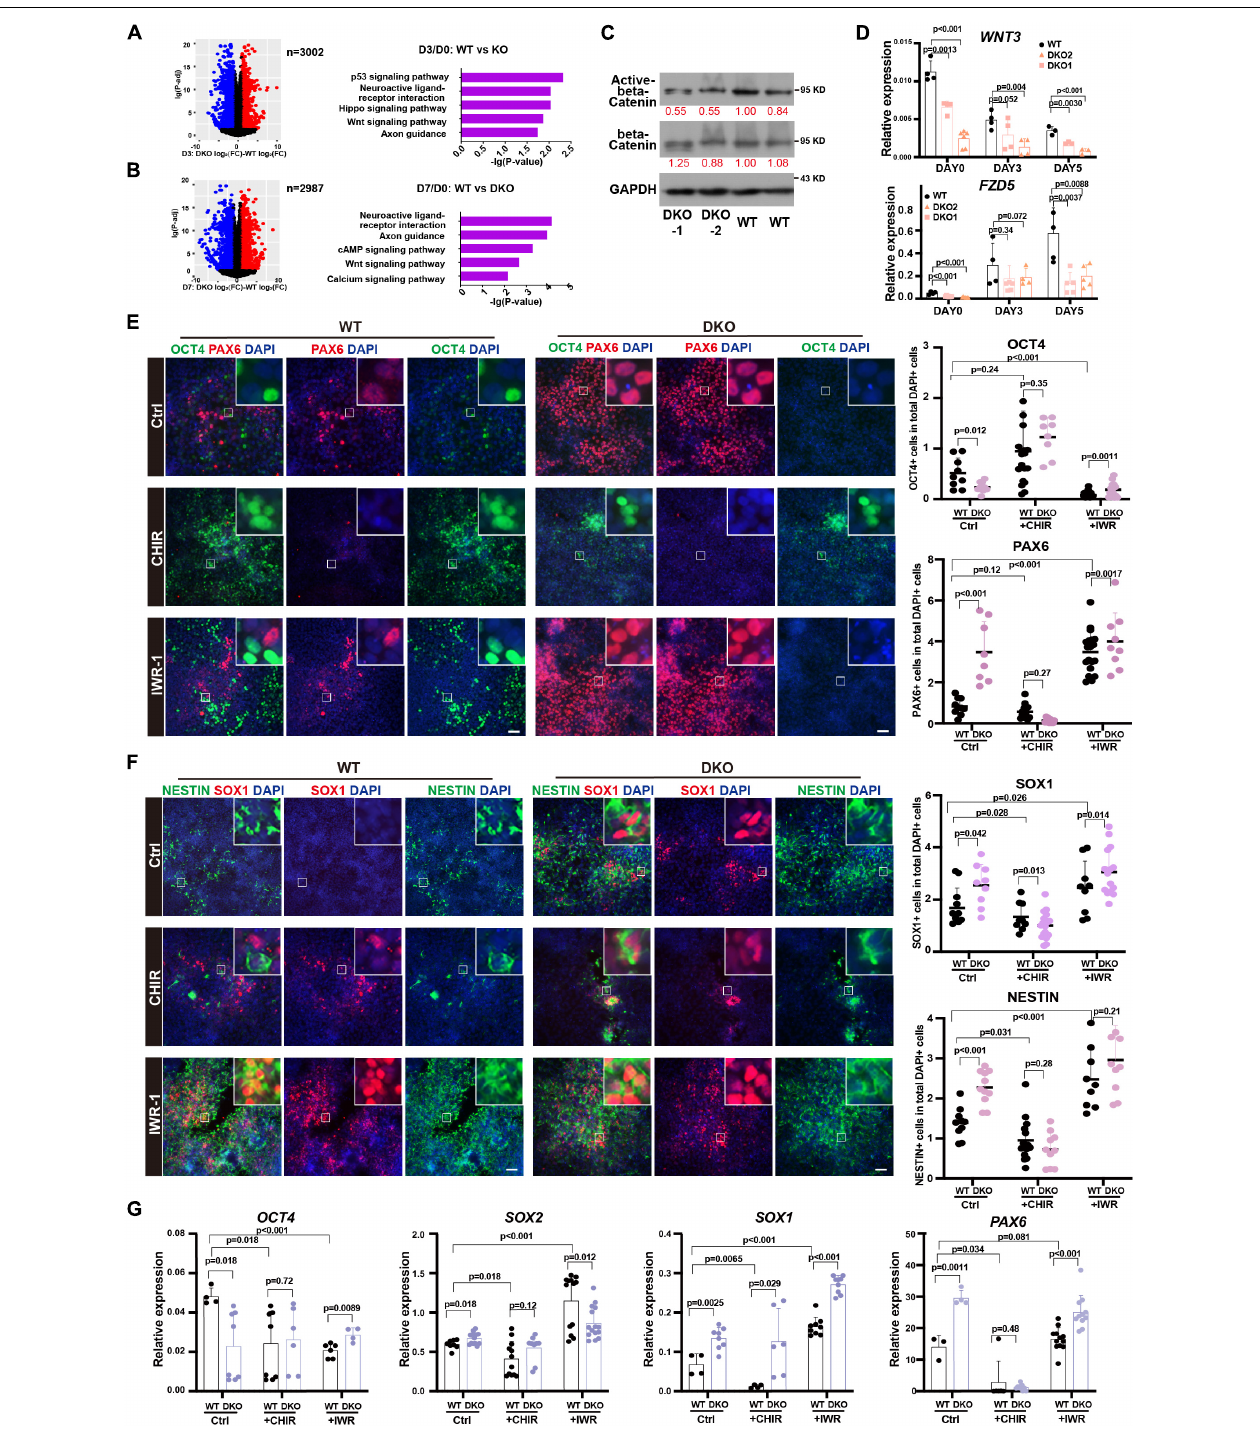
FIGURE 6 | WNT signal pathway contributed to the function of KDM6 during neuroectoderm differentiation. (A,B) KEGG analysis of abnormal activation or repression during neuroectoderm differentiation caused by KDM6 knockout based on conditional effect differential expression analysis at differentiation day 3 (A) and day 7 (B) over undifferentiated state. (C) Western blot assay showing the signal intensity of active beta-catenin and total beta-catenin in KDM6-DKO cells and wild-type cells. GAPDH works as the loading control. (D) The RT-qPCR test of WNT3 and FZD5 at different days during neuroectoderm differentiation. (E,F) The immunofluorescence test (left) and its counts (right) of the expression differences of pluripotential and NPC markers (OCT4/PAX6, NESTIN/SOX1) of HUES8 and DKO cells upon adding CHIR and IWR-1 or vehicle control. Scale bar = 50 µ m. (G) The RT-qPCR test of the expression differences of pluripotential and neural markers of HUES8 and DKO cells upon adding CHIR or vehicle